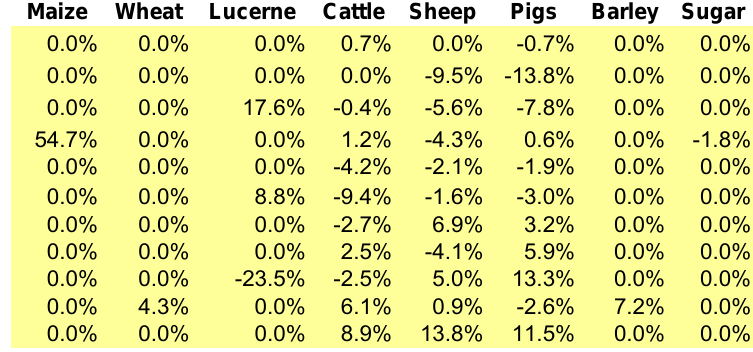
Figure 1 - Data template: monthly returns for agricultural